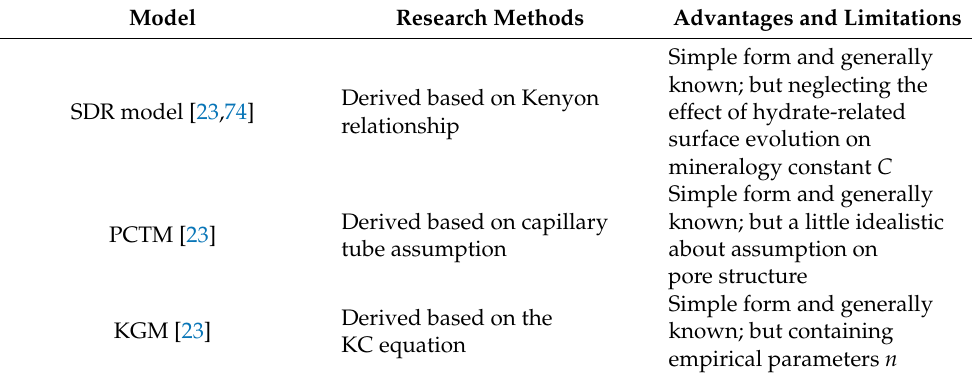
Table 1. Research methods, advantages, and limitations of classical models for permeability predic- tion of HBSs.